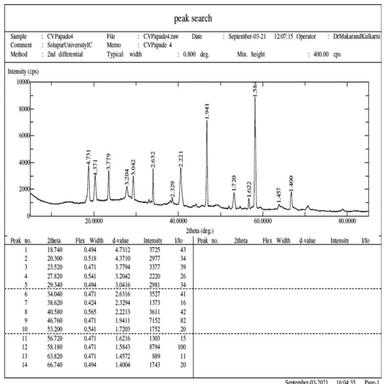
XRD analysis of 1 % nano mixed -PCM.